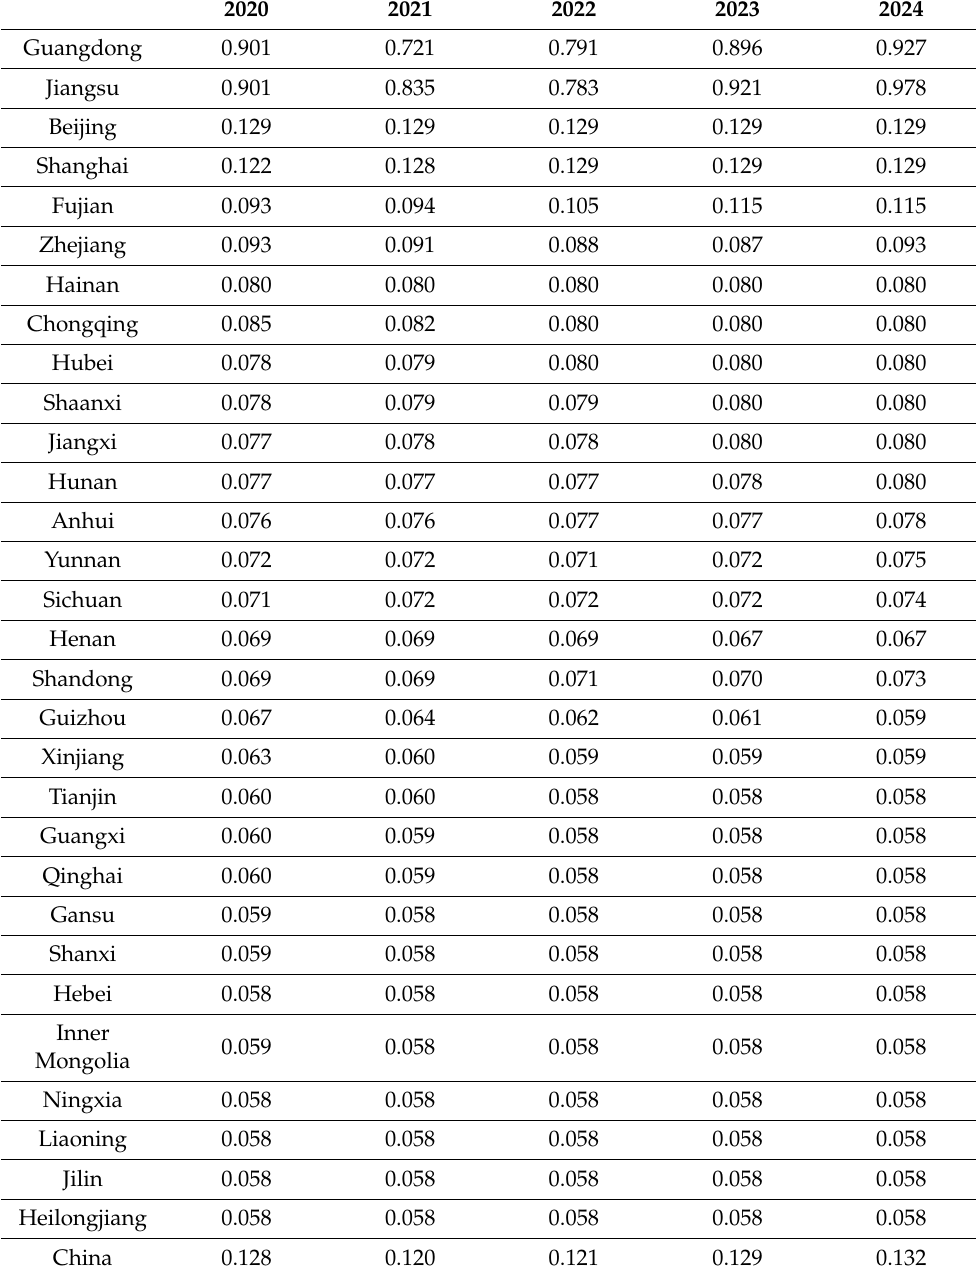
Table 9. Prediction results of the low-carbon economic efficiency value in China from 2020 to